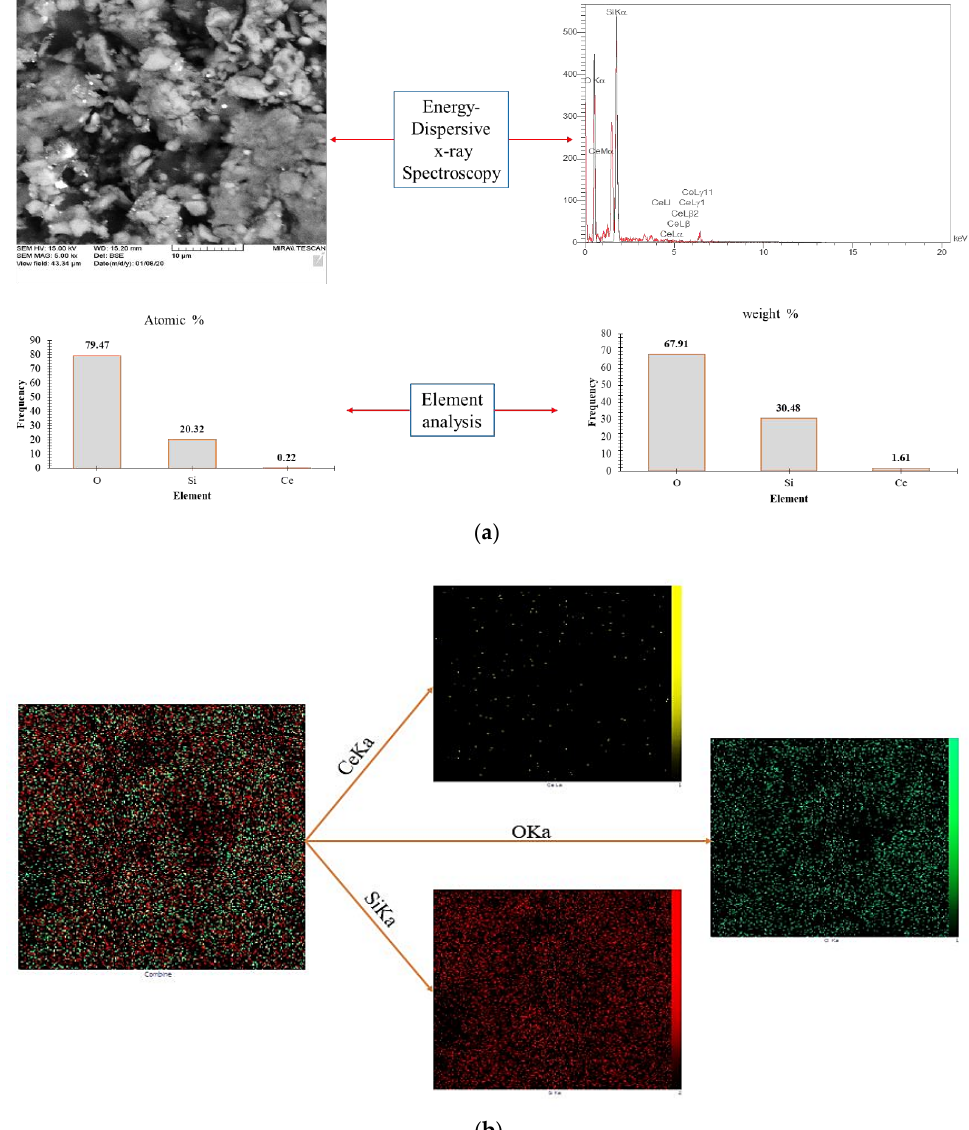
Figure 7. EDS and EDS-MAP analysis results which were used, respectively, in this research work to identify the constituent elements and the frequency distribution of the elements and the distribution and dispersion of each element found in a given area in the novel NC, quantitatively. ( a ) shows the presence of O, Ce, and Si in the novel NC. Atomic and weight analysis of O, Si, and Ce of the NC are determined as (79.47%, 20.32%, and 0.225%) and (67.91%, 30.48%, and 1.61%), respectively. ( b ) shows the distribution and dispersion of each O, Si, Ce in a given area in the NC based on the EDS-MAP,